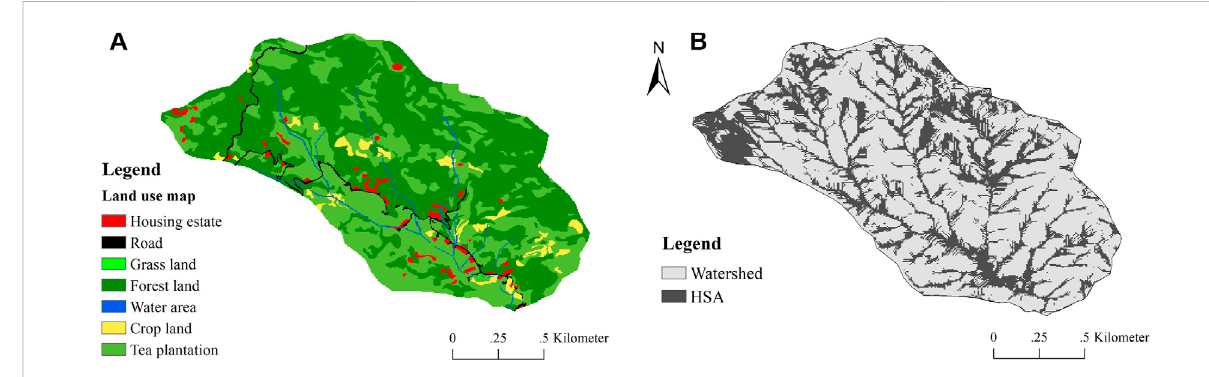
FIGURE 2 Land use types (A) and hydrologically sensitive areas (B) for the Zhangjiachong watershed created using digital elevation model (DEM) and soil